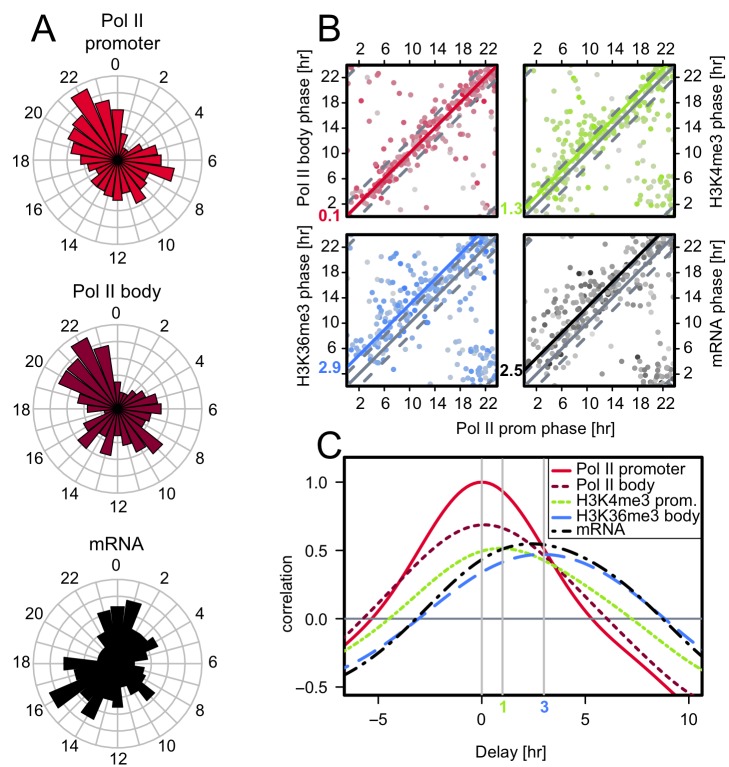
Temporal relationships of Pol II, H3K4me3, H3K36me3 profiles, and mRNA accumulation in mouse liver.(A) Phase histograms for cyclic genes. A selection of 284 genes (p<0.004, FDR = 0.3) showing cyclic patterns in all marks (see Materials and Methods) were fitted with a cosine function and the phase (peak time of the fit) was computed. These phases show a bimodal distribution for Pol II occupancy in promoters and gene bodies with maxima around ZT9 and ZT21, as well as in mRNA accumulation with a phase delay of approximately 3 h. (B) Phases for the same genes are represented in pairs, with color shade indicating p value (lower p values are darker) for the 24-h rhythm of the Pol II promoter signal. Relative to the phase of Pol II in promoters, we find high concordance for Pol II occupancy phases in gene bodies, an average delay of 1.3 h for H3K4me3 phases, and more spread H3K36me3 and mRNA phases with an average delay of about 3 h. Colored lines are mean-square regressions with intercepts corresponding to the average delays, as indicated in color. The thin dashed lines indicate ±2 h delays. (C) Temporal cross-correlation analysis. Using the same gene selection, we applied Fourier interpolation to obtain a continuous time trace (see Figure 3C,D and Figure 4D,E) and computed average cross-correlations between each mark and the corresponding Pol II promoter trace. Pol II occupancies in promoters and gene bodies are well-correlated and simultaneous, and H3K4me3 lags by about 1 h on average, whereas mRNA and H3K36me3 are phase-delayed by about 3 h. The same figure is shown for a more permissive selection (Figure S8, n = 752, p<0.018, FDR = 0.5).